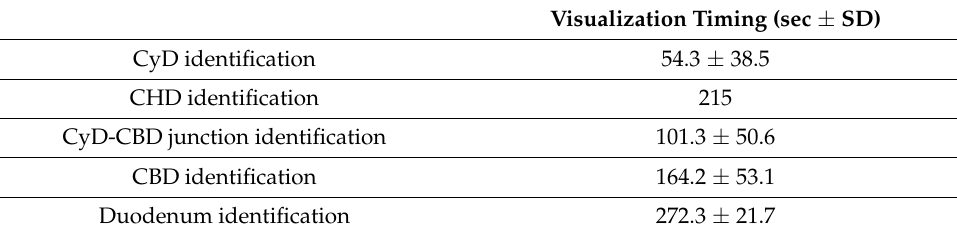
Table 3. Timing of visualization of biliary structures in the IC-ICG group.